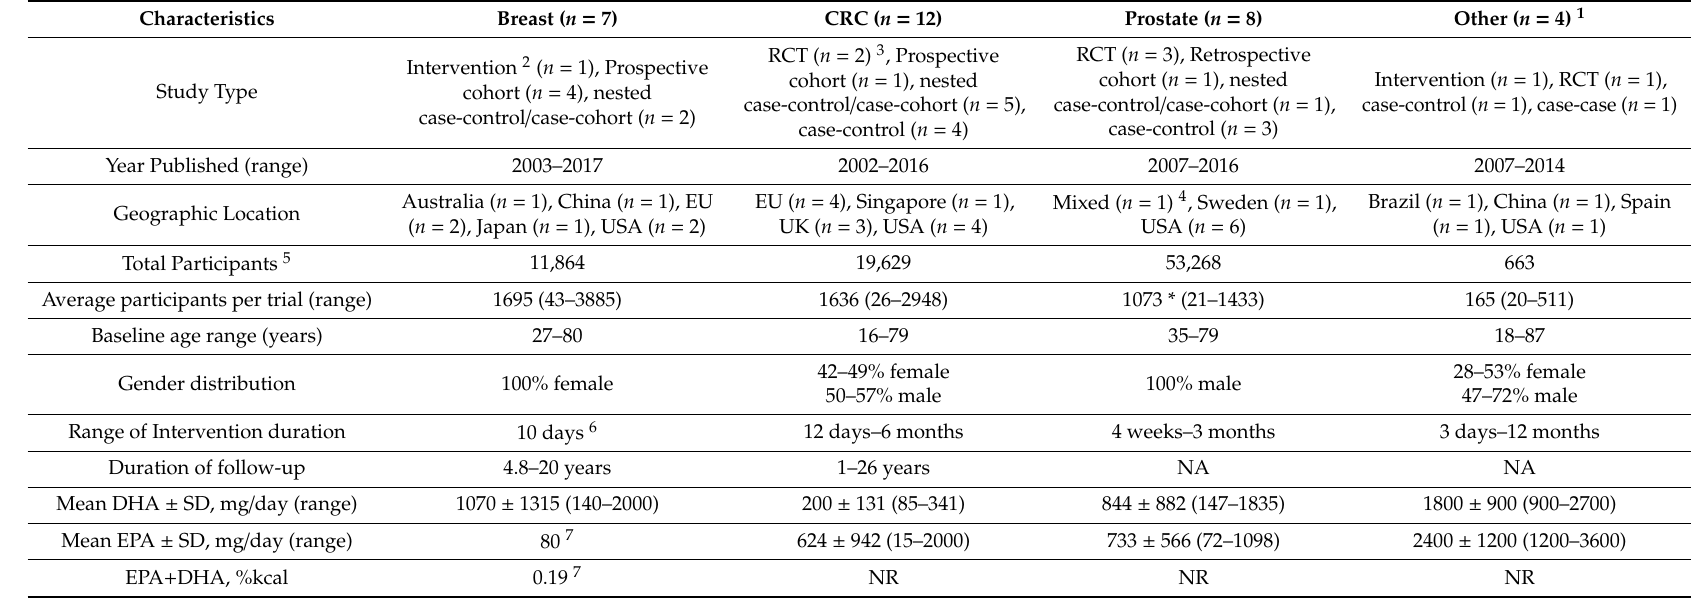
Table 1. Summary characteristics of 31 unique human studies reporting the relationship between risk and other cancer-related outcomes associated with dietary omega-3 long-chain polyunsaturated fatty acids (n-3 LC-PUFA) and